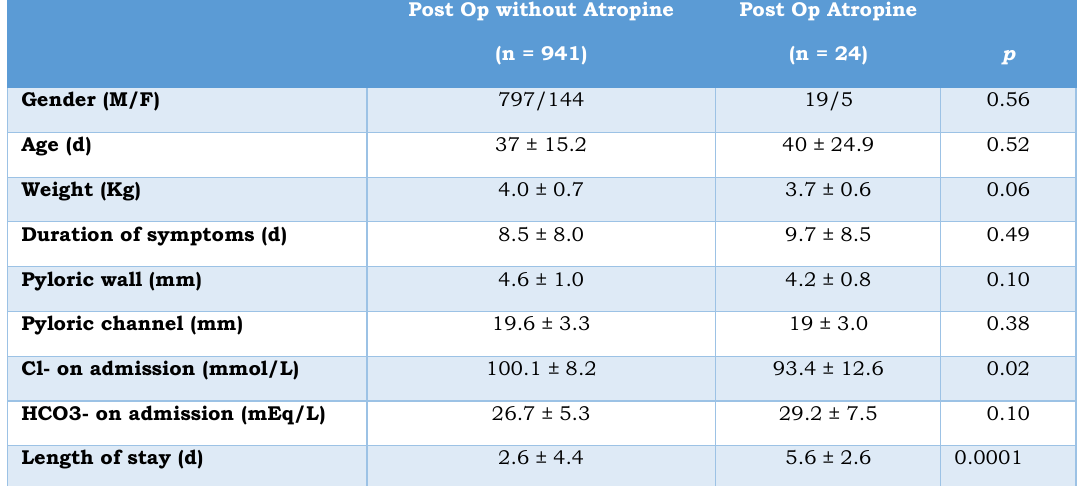
Table 1. Infant demographics and comparison of